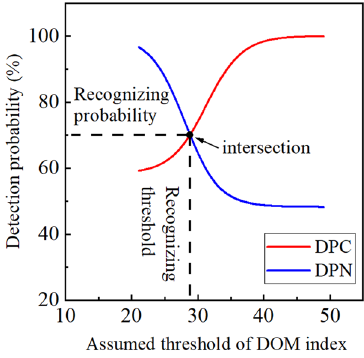
Fig. 6 Graphic diagram for the relationship between the assumed threshold of DOM index and DPN and DPC. The horizontal dashed line shows the detection probability ( y ) of intersection between two curves, which was de fi ned as the applicability of DOM index in recognizing CKDu groundwater, and the vertical dashed line shows the threshold value ( x ) of intersection between two curves, which was de fi ned as recognizing